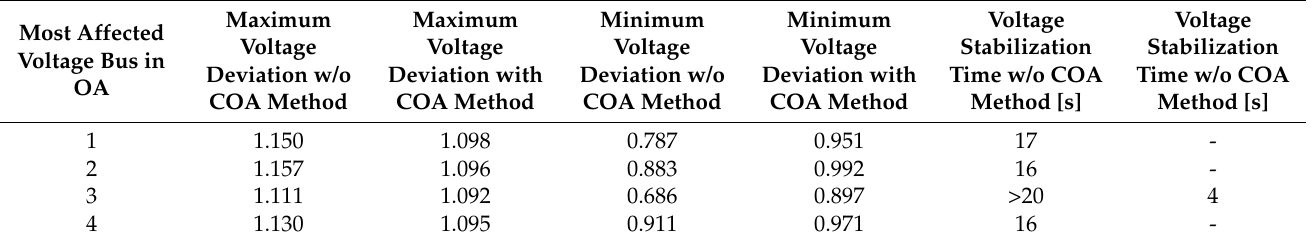
Figure 19. P–V curves for normal and contingency operation in operational area 3 (load shedding calculation).